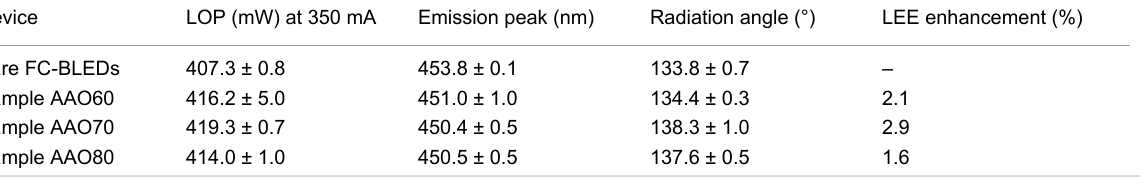
Table 1: Light output power (LOP), emission peak, radiation angle, and light extraction efficiency (LEE) enhancement of bare FC-BLEDs, samples AAO60, AAO70, and AAO80. Device